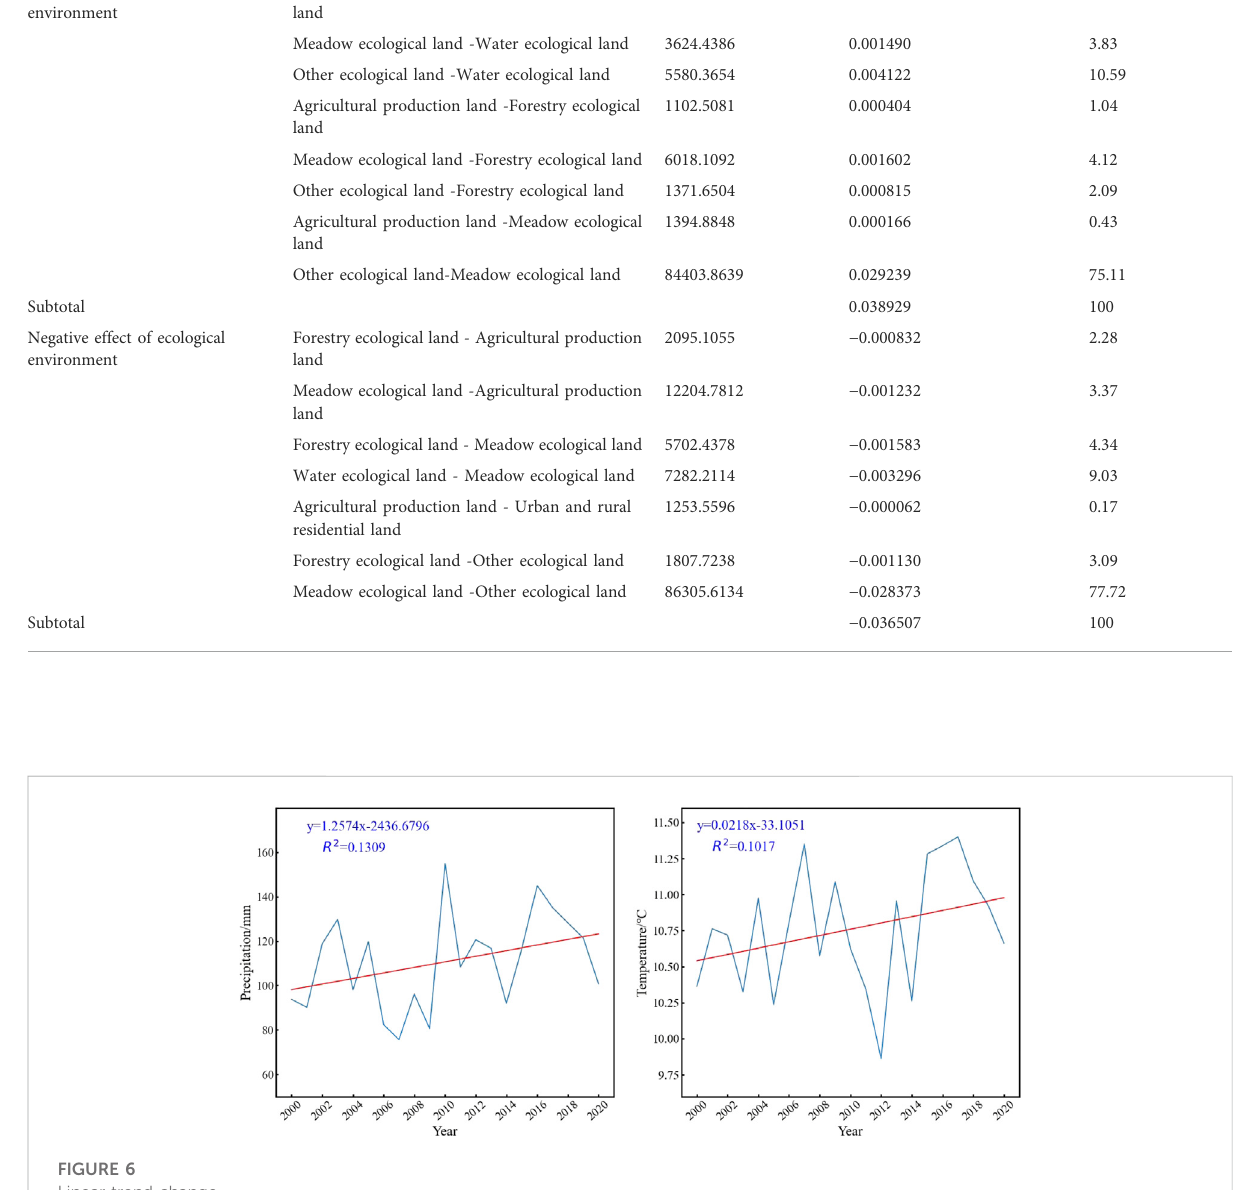
FIGURE 6 Linear trend